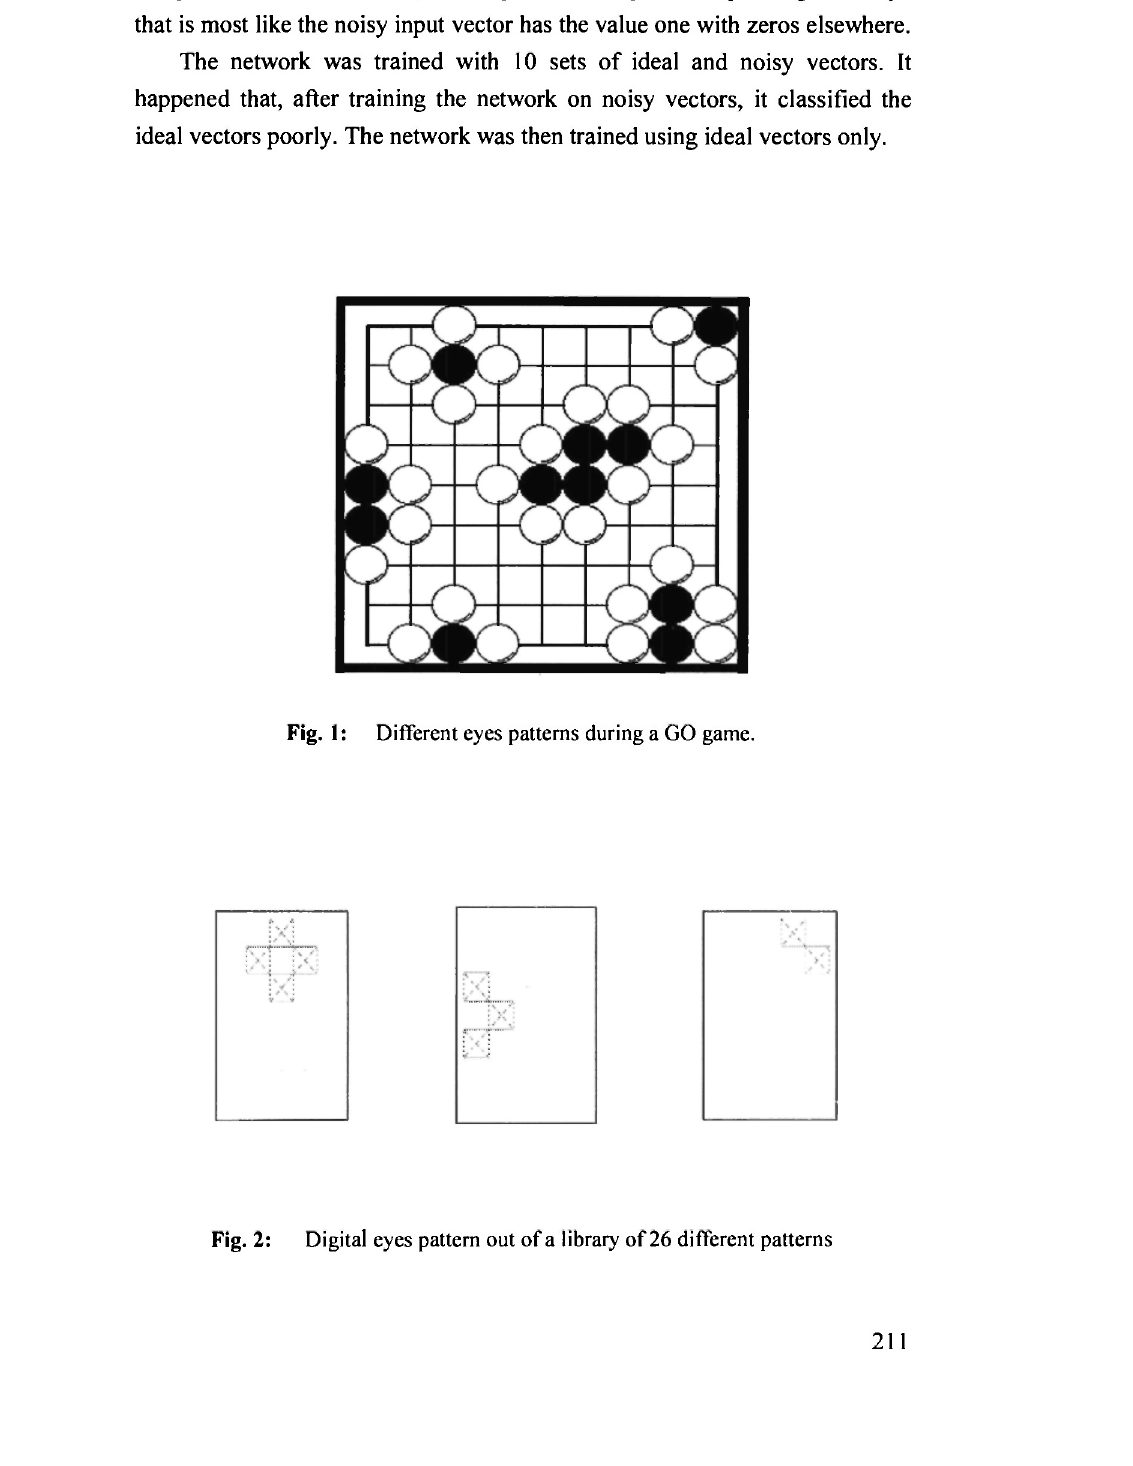
Fig. 2: Digital eyes pattern out of a library of 26 different patterns